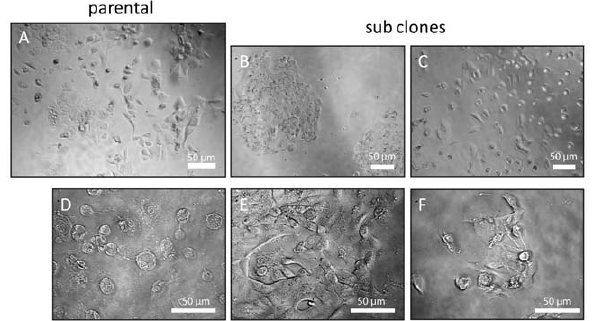
Figure 1. Growth behaviour and cell morphology. Phase contrast images are presented of JoPaca-1 parental cells and subclones showing different growth characteristics and morphologies. A. JoPaca-1 parental cell population. B,C. Two different growth characteristics can be observed: close-contact island formation (B) and no-contact spreading (C). D–F. Three different cell shapes were observed: round and vesicular (D), spindle-like (E), and pseudo-pod forming (F) cells.